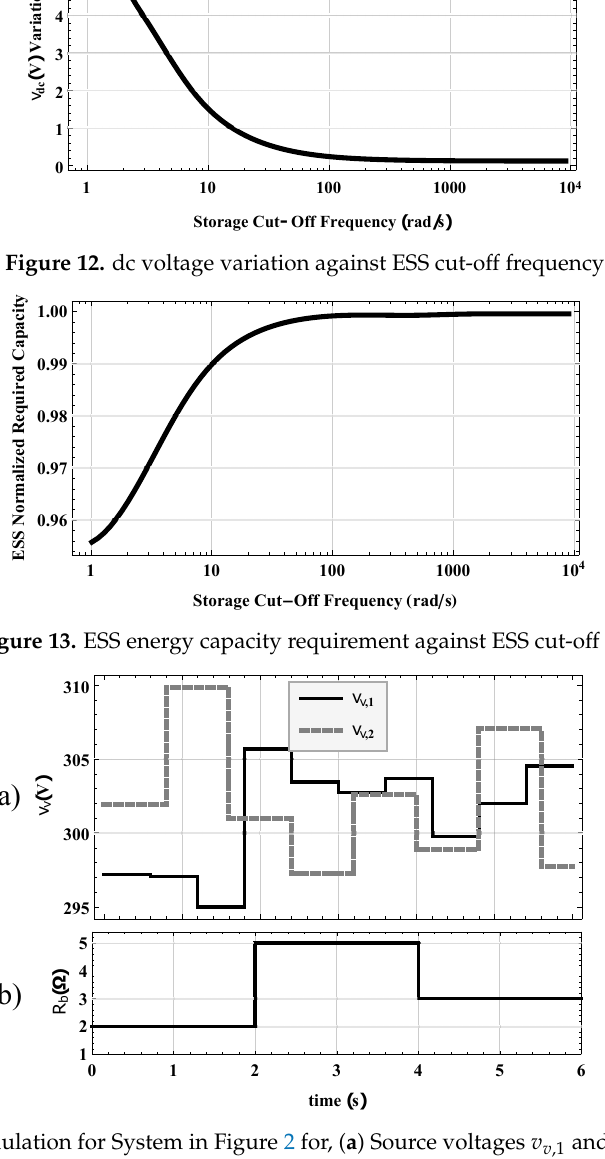
Figure 14. Simulation for System in Figure 2 for, ( a ) Source voltages v v ,1 and v v ,2 and, ( b ) Load R b